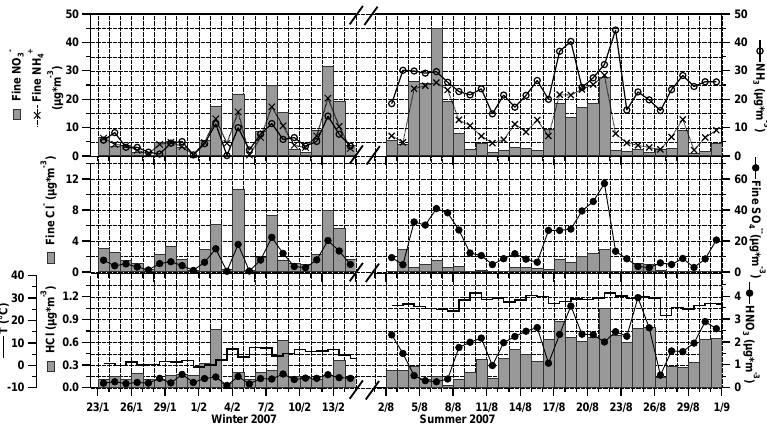
Fig. 1. Temporal trends of fine particulate Cl − , NO − winter and summer measurements, carried out on a 24-h basis, at